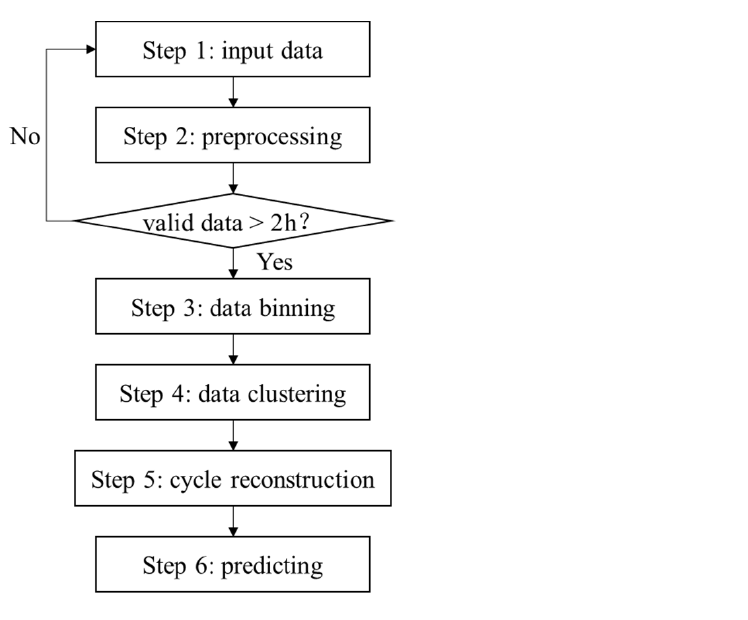
Figure 1. The binning-reconstruction model.